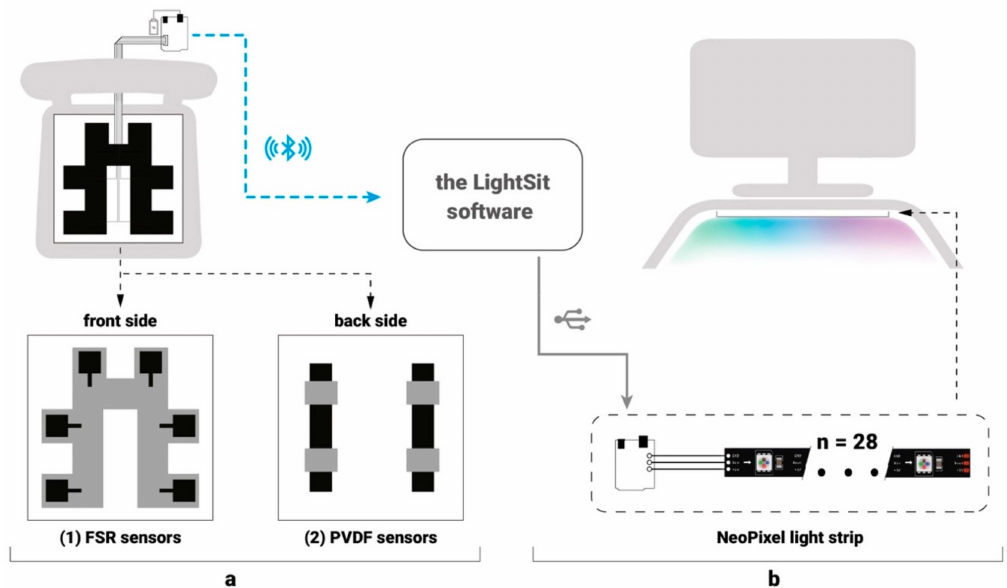
Figure 2. The technical implementation of the LightSit system. ( a ) A seat pad equipped with (1) six FSR sensors and (2) two PVDF sensors. ( b ) A flexible light strip that can be used as an ambient